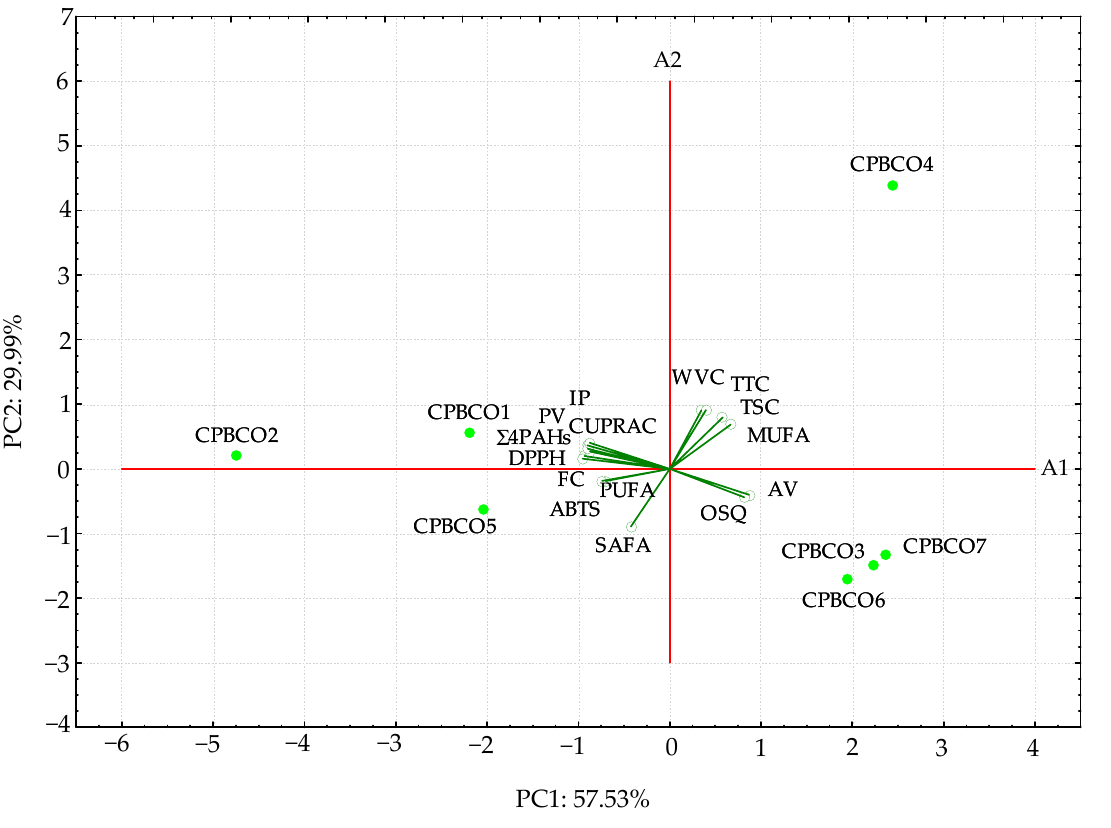
Figure 2. Biplot of scores and loadings of data obtained for chemical and overall sensory characteristics of the seven cold-pressed black cumin oils.